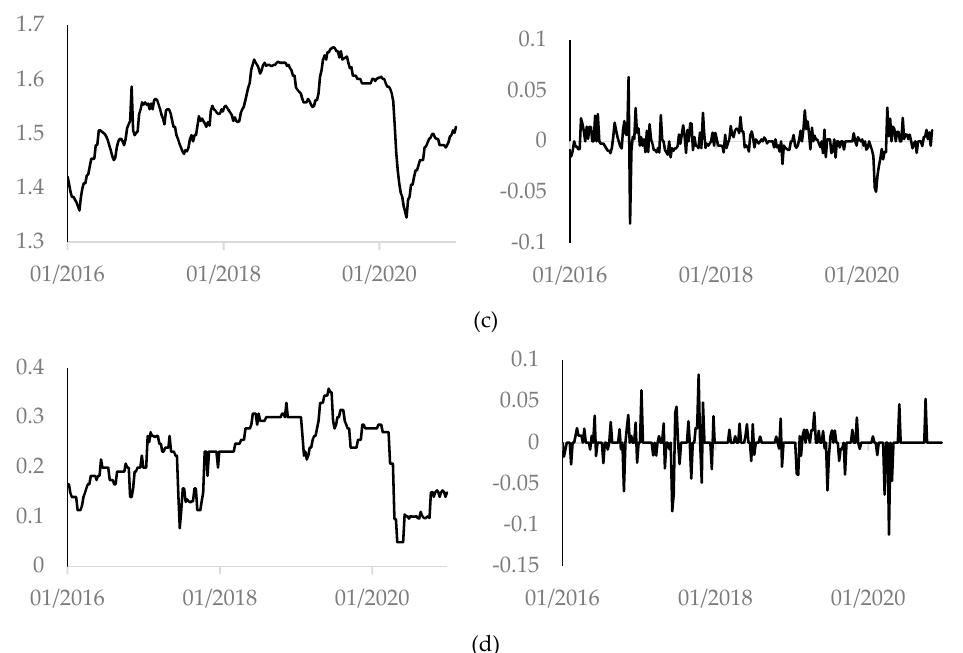
Figure 1. Pb95 gasoline logarithmic weekly prices (left panel) and returns (right panel) in the Czech Republic ( a ), Hungary ( b ), Poland ( c ) and Slovakia ( d ) from January 2016 through December 2020. Source: own elaboration.